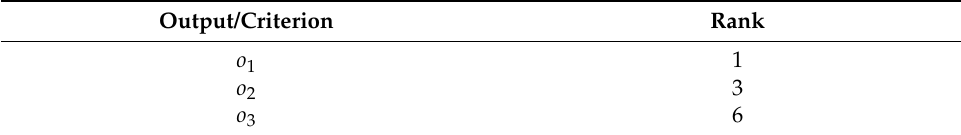
Table 7. Ranks of criteria outputs after introducing white